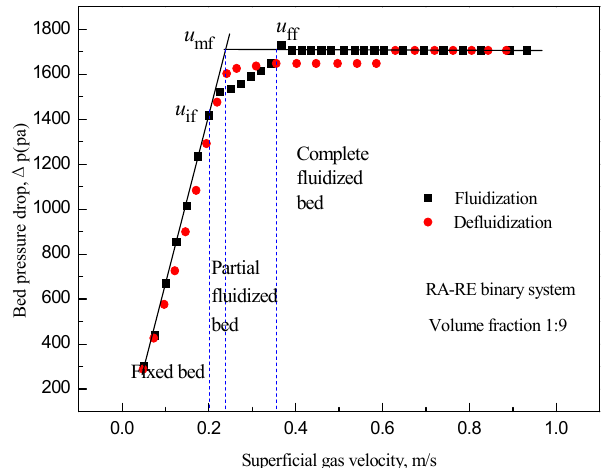
Figure 3. Characteristic fluidization velocities of the binary system ( V b = 0.9).